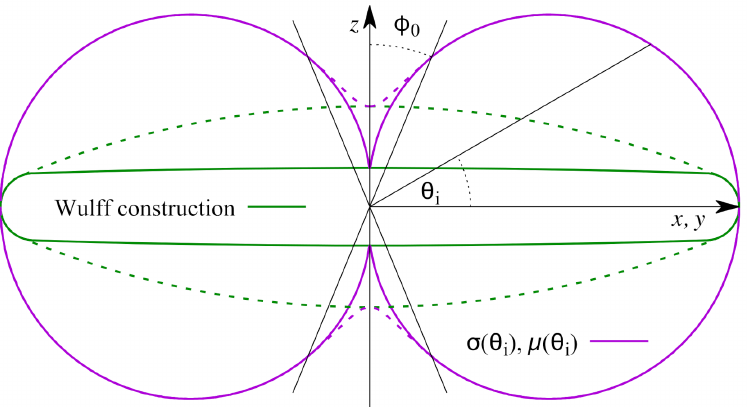
Figure 1. Parametric plot of the orientation dependence of the interface energy and mobility according to Equation (10) together with the parametric Wulff construction of the equilibrium shape of a particle. The maximum interfacial mobility is set as µ max = µ 0 = 1 × 10 − 19 m 4 /Js, accord-